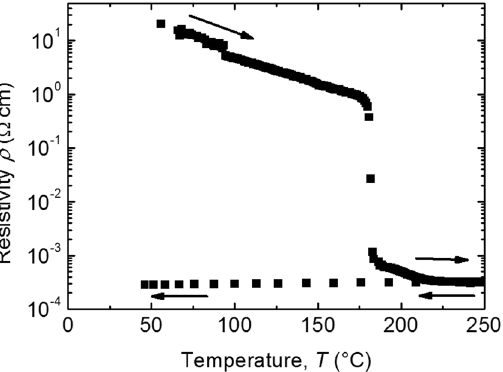
Figure 1. Electrical resistivity changes in GeTe-1 following thermal annealing, where the amorphous-to- crystalline phase transition is evident at 180 °C.